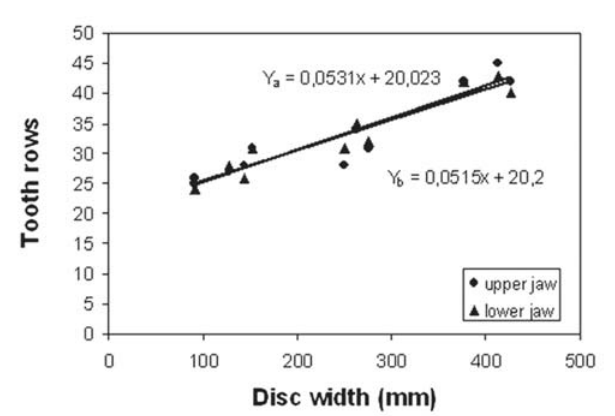
Fig. 7. Number of longitudinal tooth rows in upper (a) and lower (b) jaws of Potamotrygon boesemani , relative to disc width. Adjusted straight lines of both regression functions nearly coincident.